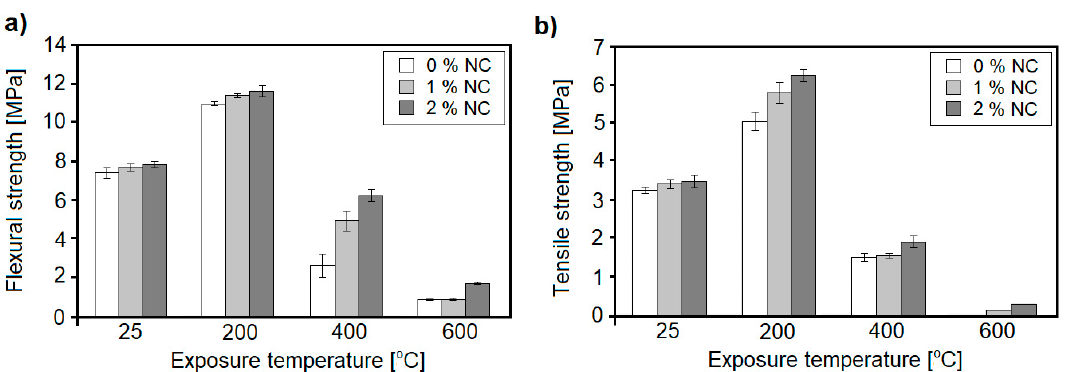
Figure 12. Flexural strength ( a ) and tensile strength ( b ) of cement mortars, containing NC, exposed to elevated temperature. Reproduced with permission from [64]. Copyright Elsevier, 2018.